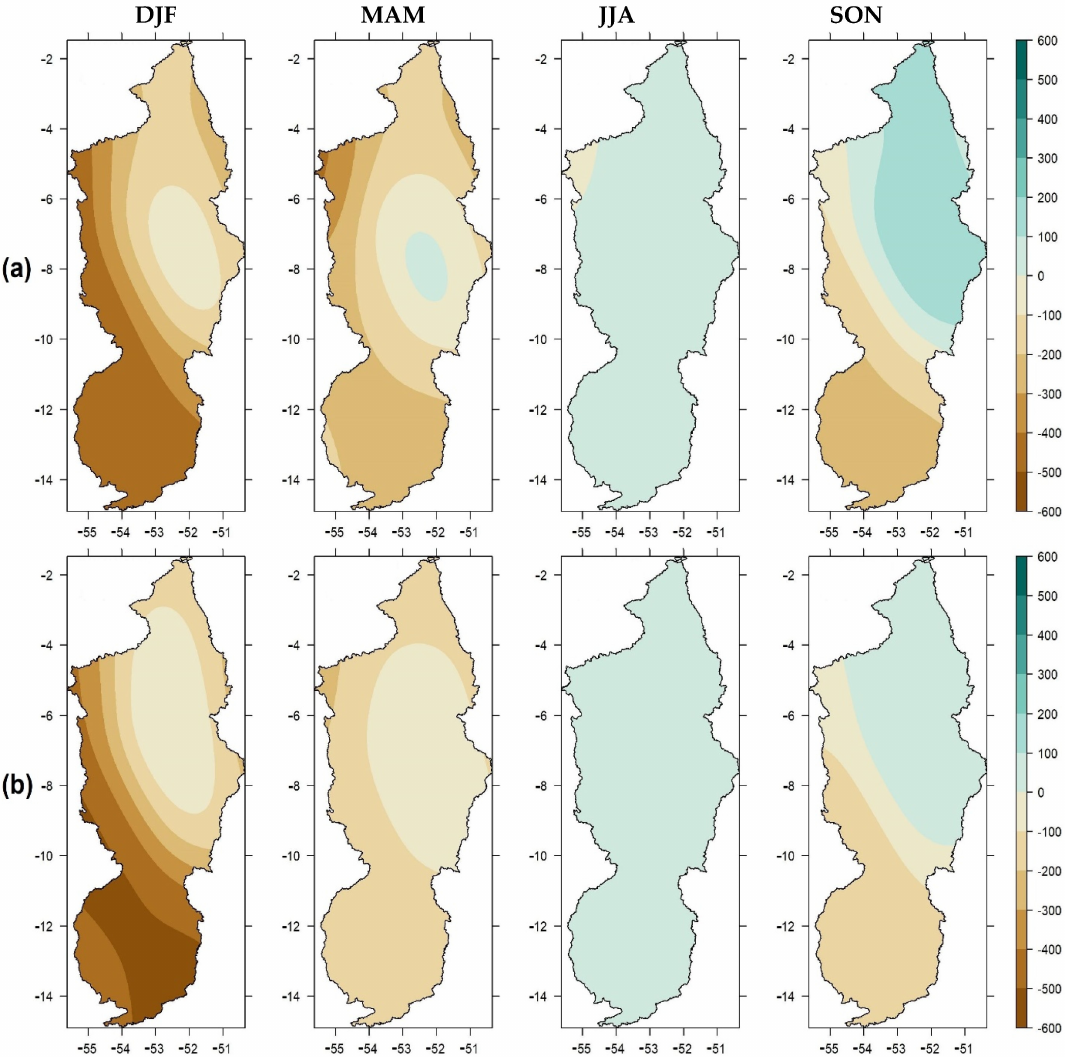
Figure 8. The same as in Figure 6, but for the 2051–2080 period.